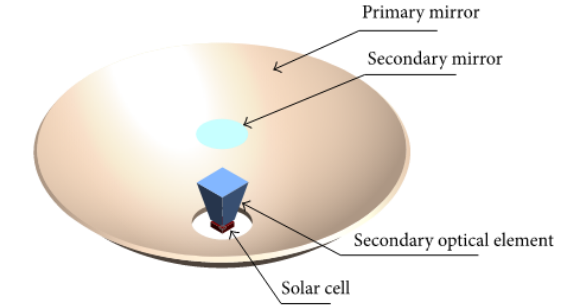
Figure 38. Optical system consisting of a mirror as the POE and a pyramid as the SOE proposed by Chen et al. [72]. Reprinted from Yi. Chen et al., Optimal Design of a Secondary Optical Element for a Noncoplanar Two-Reflector Solar Concentrator. International Journal of Photoenergy 2015, 1–8, with permission from